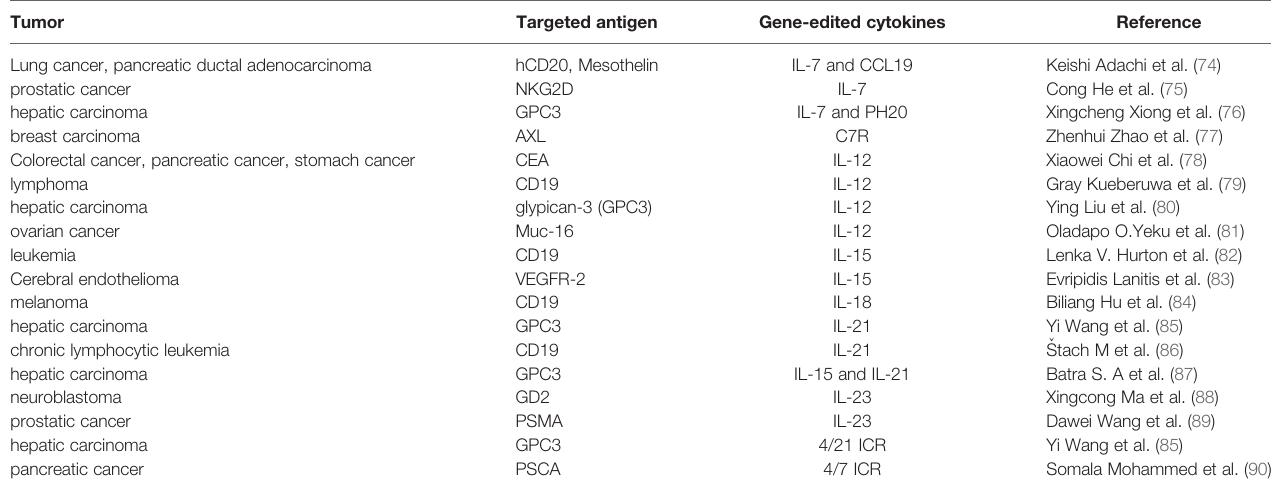
TABLE 2 | Summary of preclinical studies on the use of CAR-T cells co-expressing cytokines in the treatment of malignant tumors.